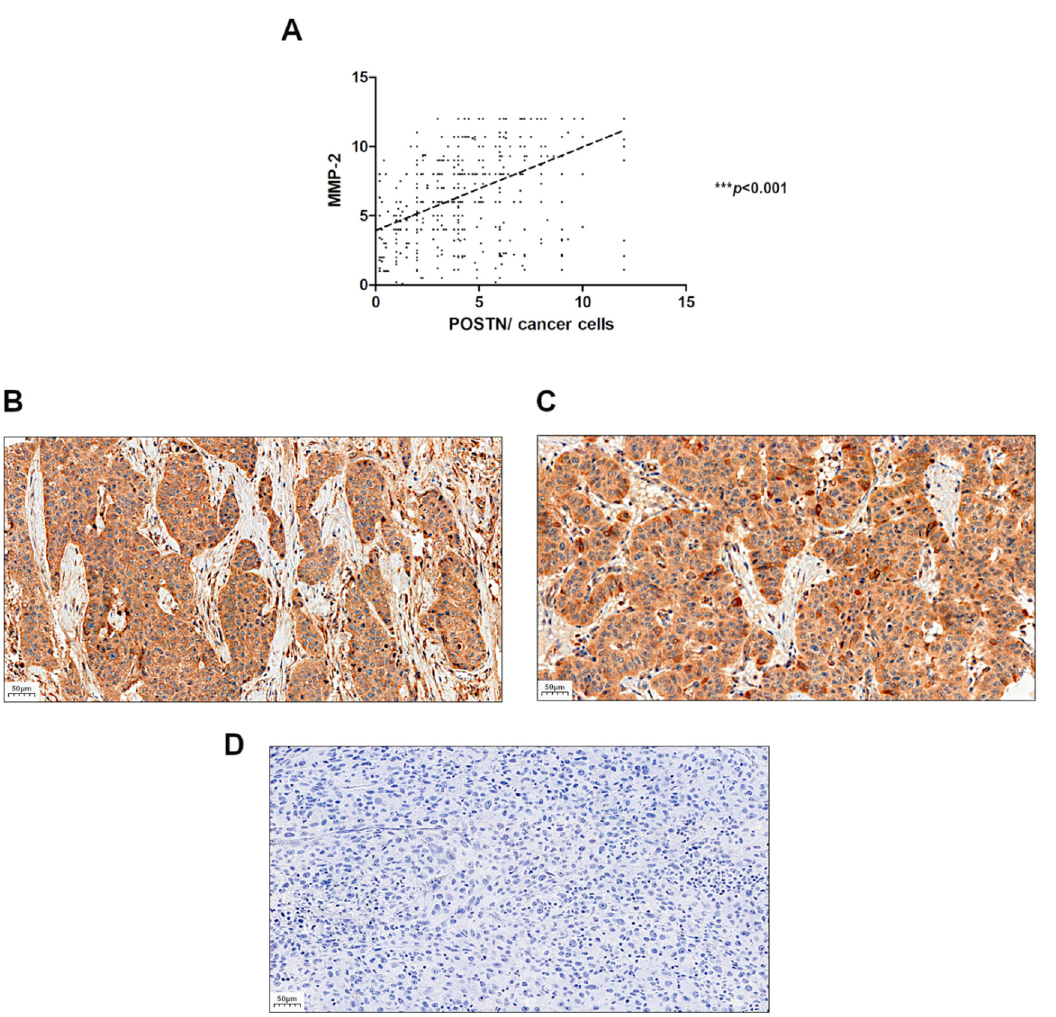
Figure 4. Correlation of periostin (POSTN) expression level with matrix metalloproteinase-2 (MMP-2) expression level in ( A ) non-small cell lung carcinoma (NSCLC), (r = 0.5262, *** p < 0.001). Immunohistochemical images with cytoplasmic MMP-2 expression in the tissue of two non-small cell lung carcinoma (NSCLC) subtypes: ( B ) squamous cell cancer (SCC) and ( C ) adenocarcinoma (AC). ( D ) negative control (NC). Magnification 200×. Bar =50 µm.